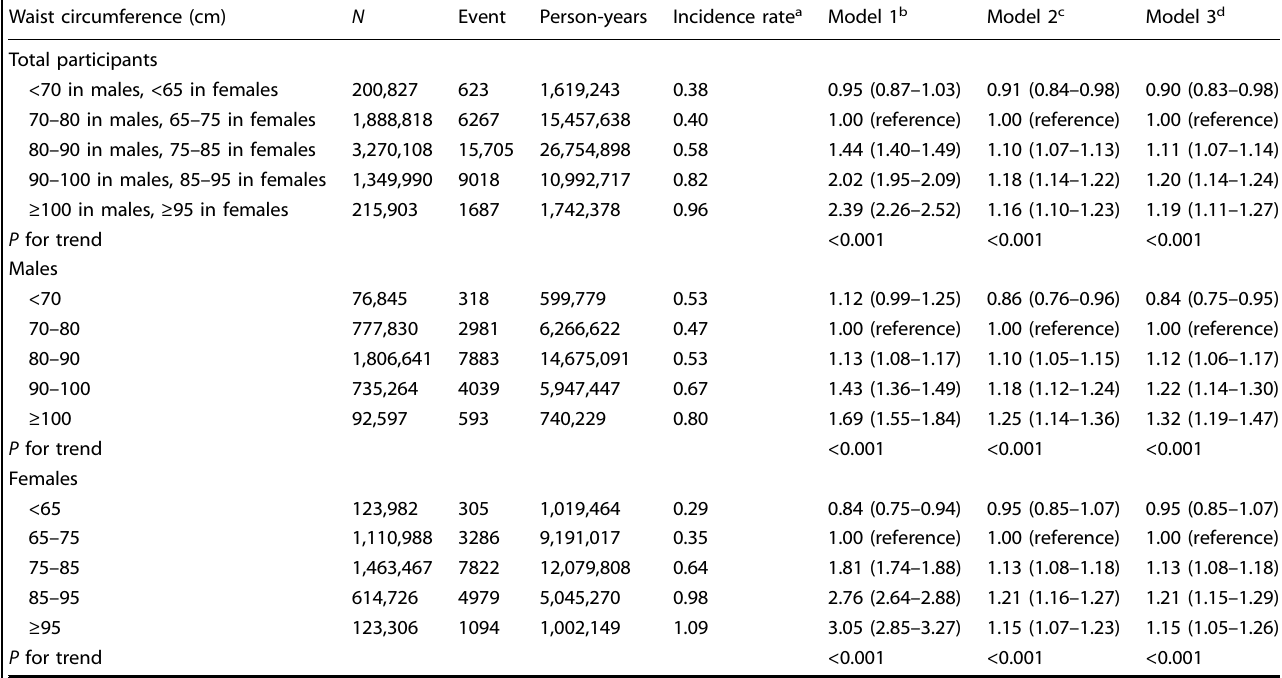
Table 2. Longitudinal associations between waist circumference categories and incident Parkinson ’ s disease. Waist circumference (cm)